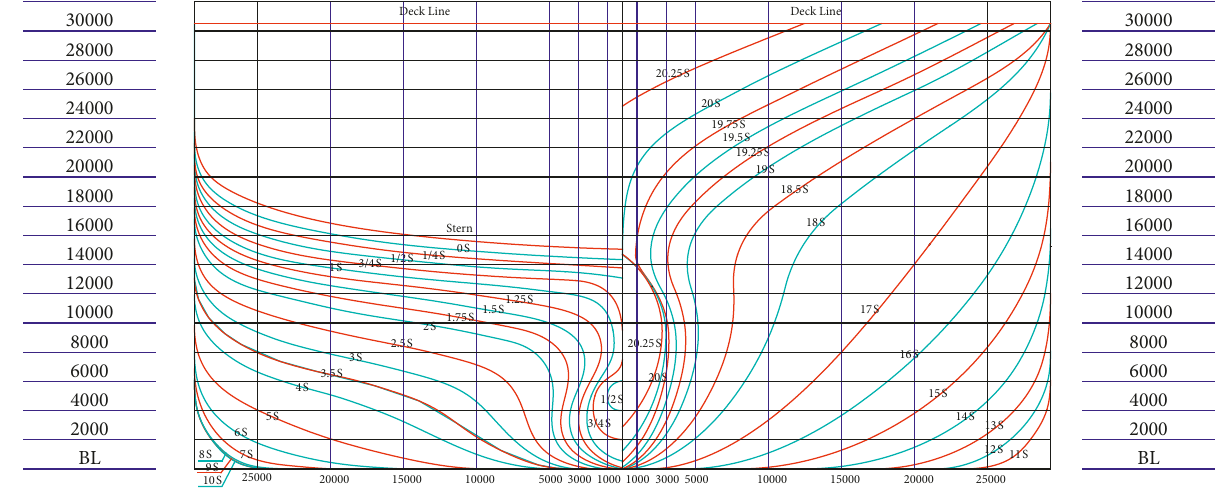
Figure 3: Offset lines of the containership. Table 1: Main